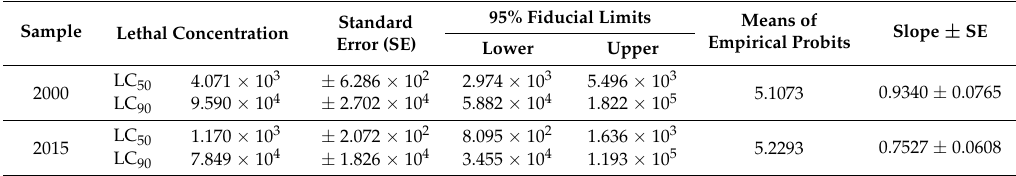
Table 2. Concentration-response values for neonate T. leucotreta larvae calculated from three replicates of each of two Cryptophlebia leucotreta granulovirus samples produced in 2000 and